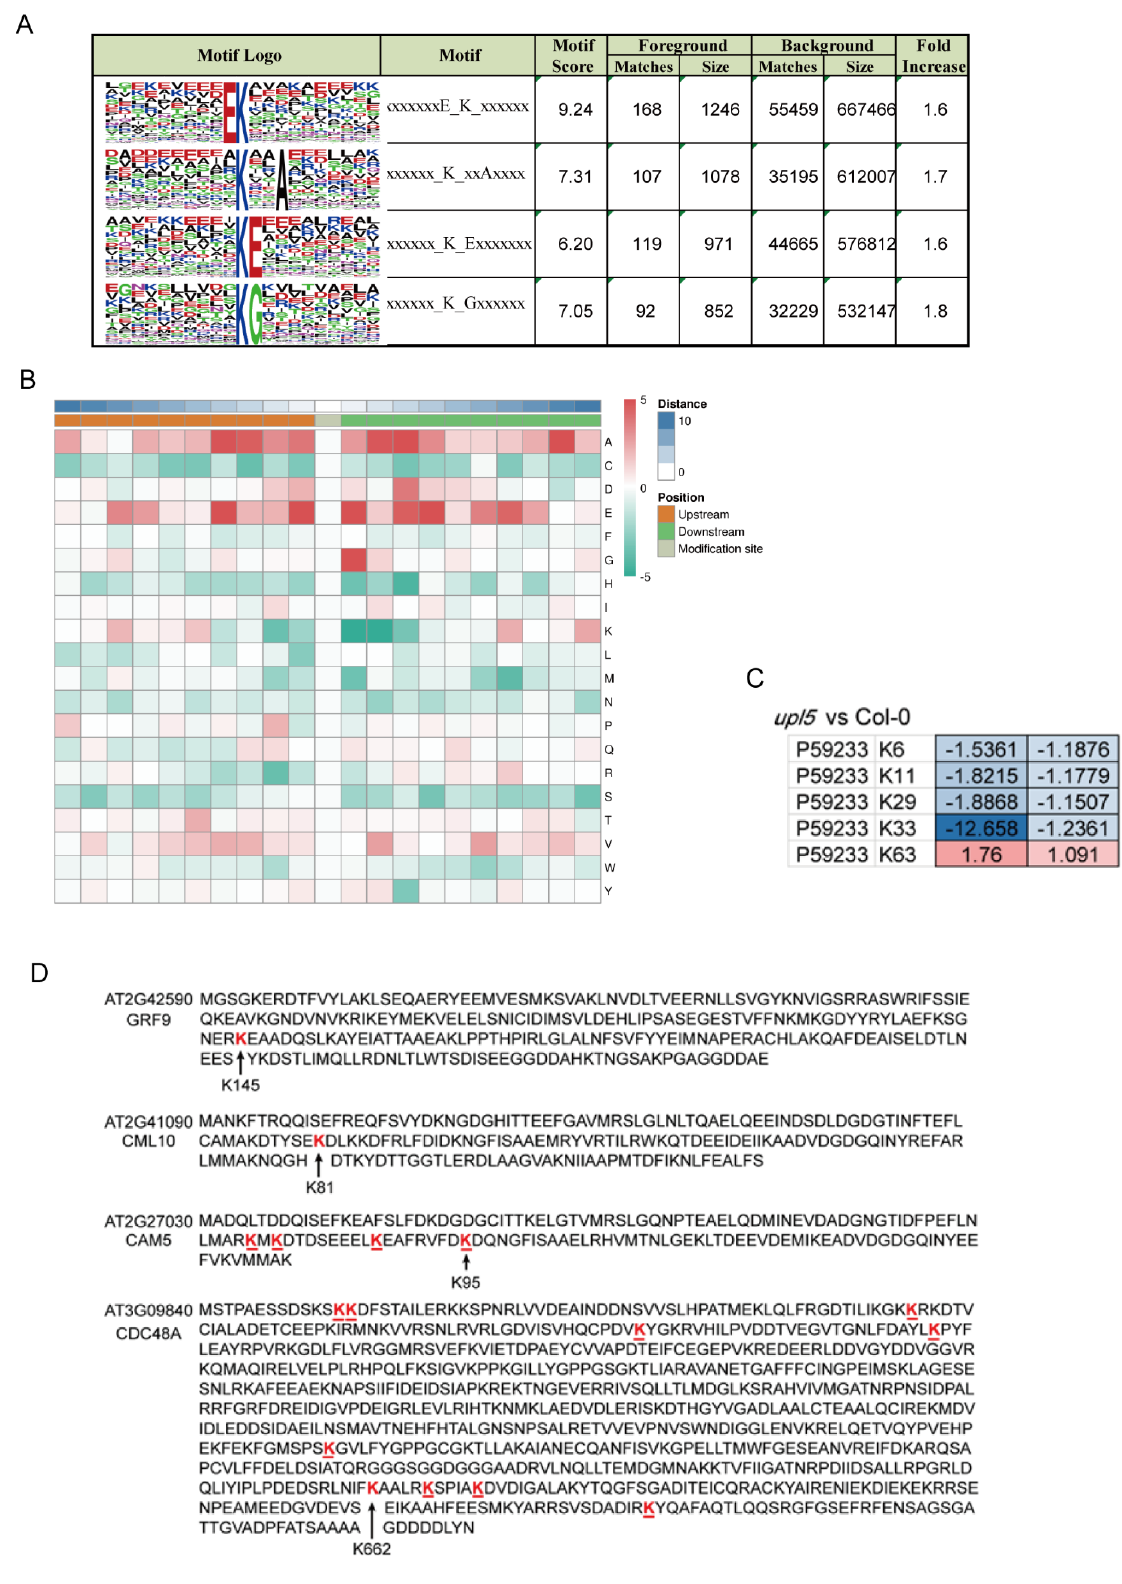
Figure 4. Lysine footprints (Kub-sites) of UPL5-related differentially ubiquitinated conjugates (changed fold 1.5, p value < 0.05). ( A ) The consensus ubiquitin attachment motif identified by